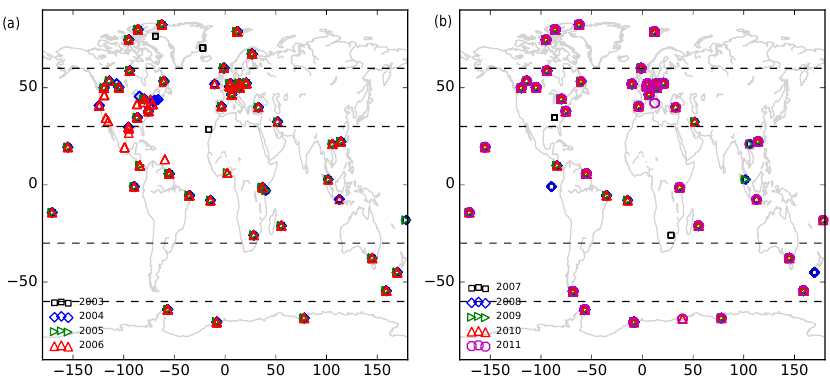
Figure 5. Collocated geolocations of satellite data and ozone sonde stations used in the validation. (a) Collocations for years 2003–2006 as labelled. (b) Same for years 2007–2011. Collocations correspond to Fig. 8. The horizontal dashed lines are at 60 and 30 ◦ N and 30 and 60 ◦ S.